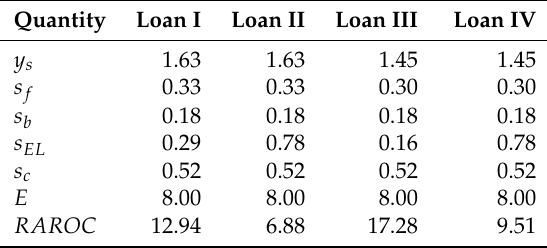
Table 3. Cost components RAROC for the four example loans assuming rating grade 3 and using the Standardized Approach for computing E . All results are percentage